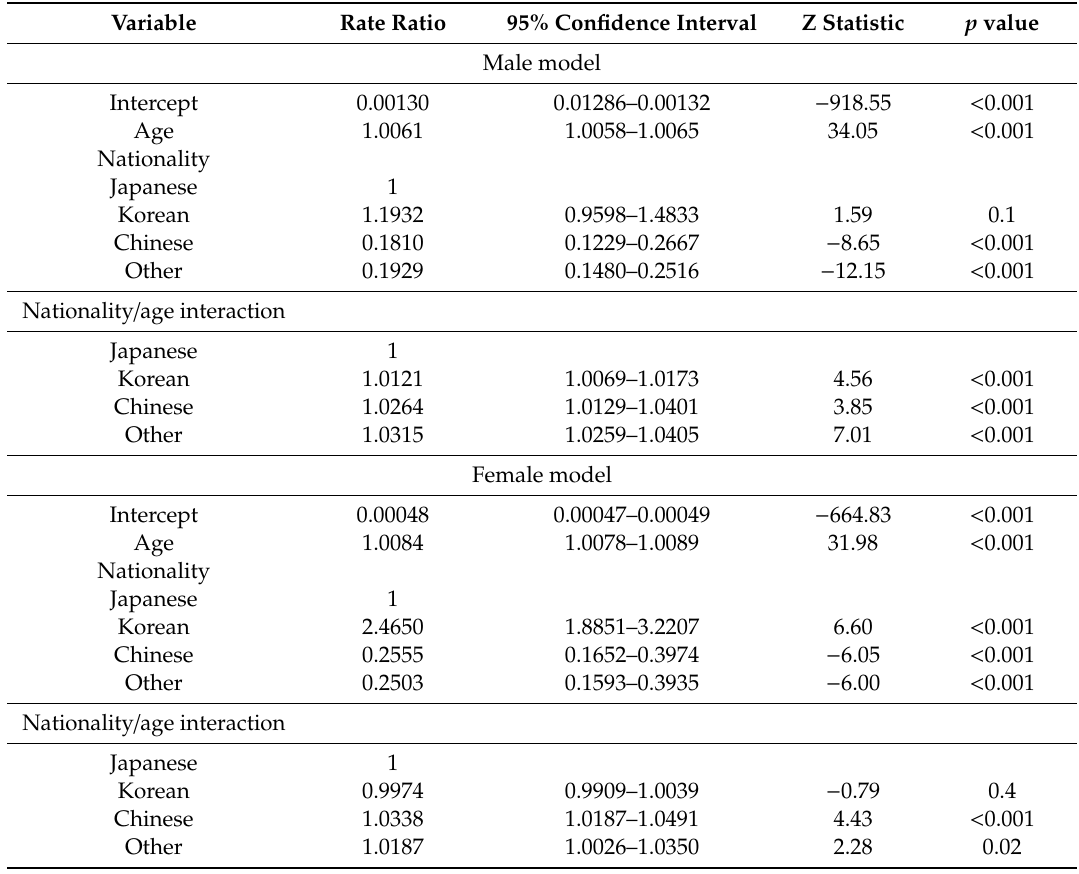
Table 2. Poisson regression model of suicide mortality risk by